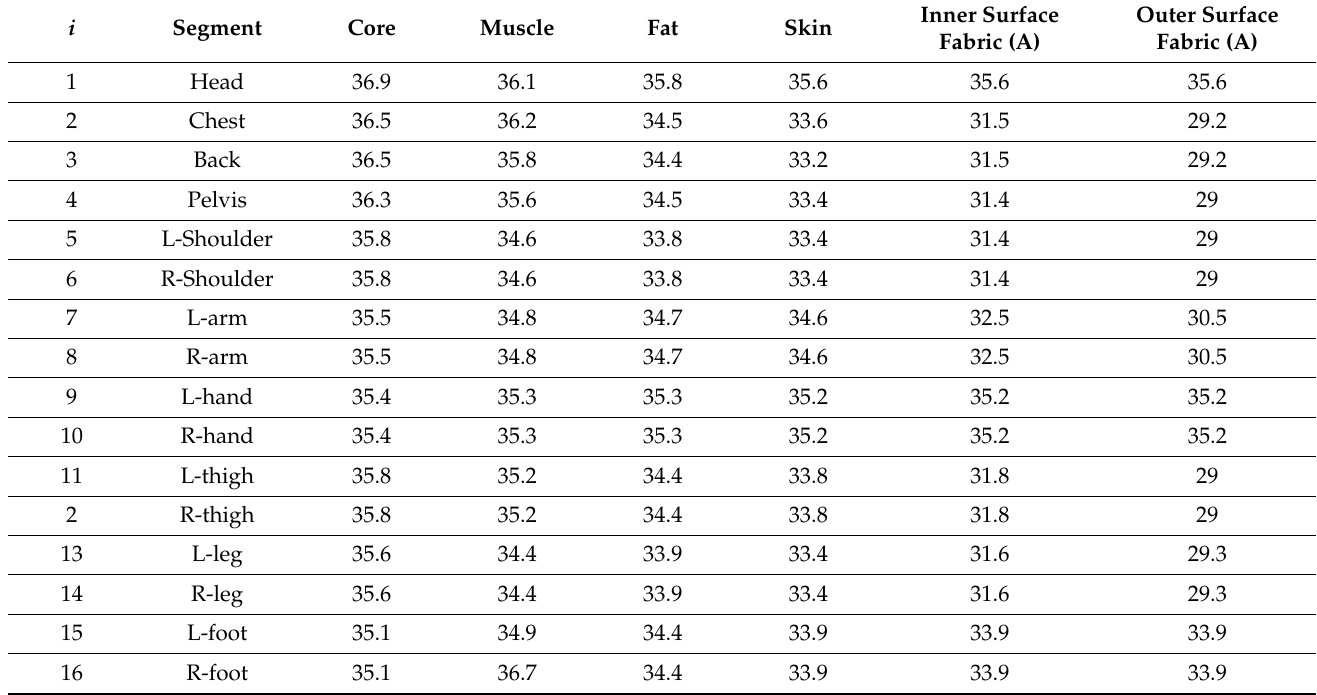
Table 5. Tset(i,j) (W/ ◦ C), Central blood temperature = 36.7 ◦